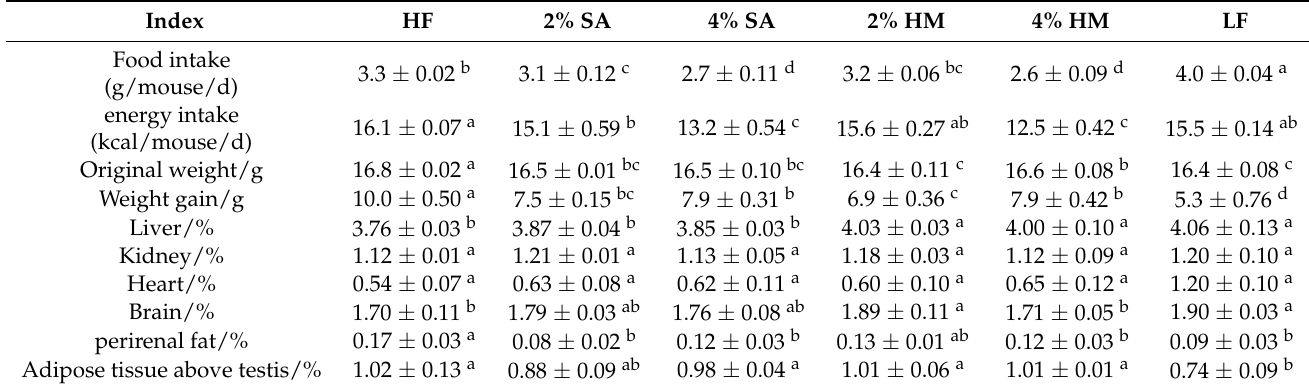
Table 1. Effects of phospholipids on growth indexes of hyperlipidemia